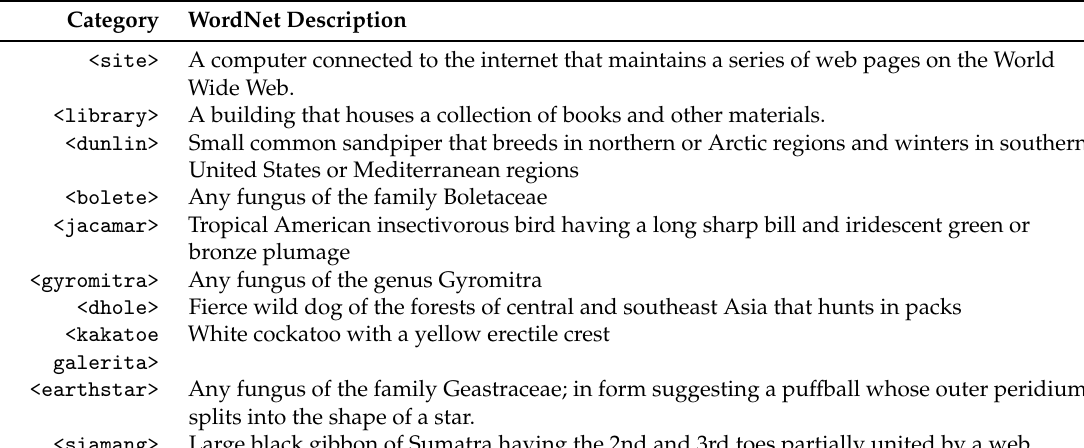
Table 1. ILSVRC2012 categories, selected to form smaller dataset D (cid:48) . <web site> and <library> are assumed to be easy for people to recognize, the rest are expected to be hard. Descriptions provided by